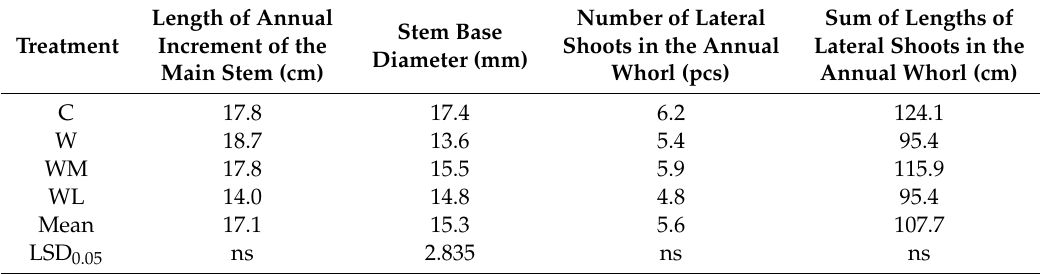
Table 1. Growth characteristics of young Scots pine trees (presented as the average of three years of